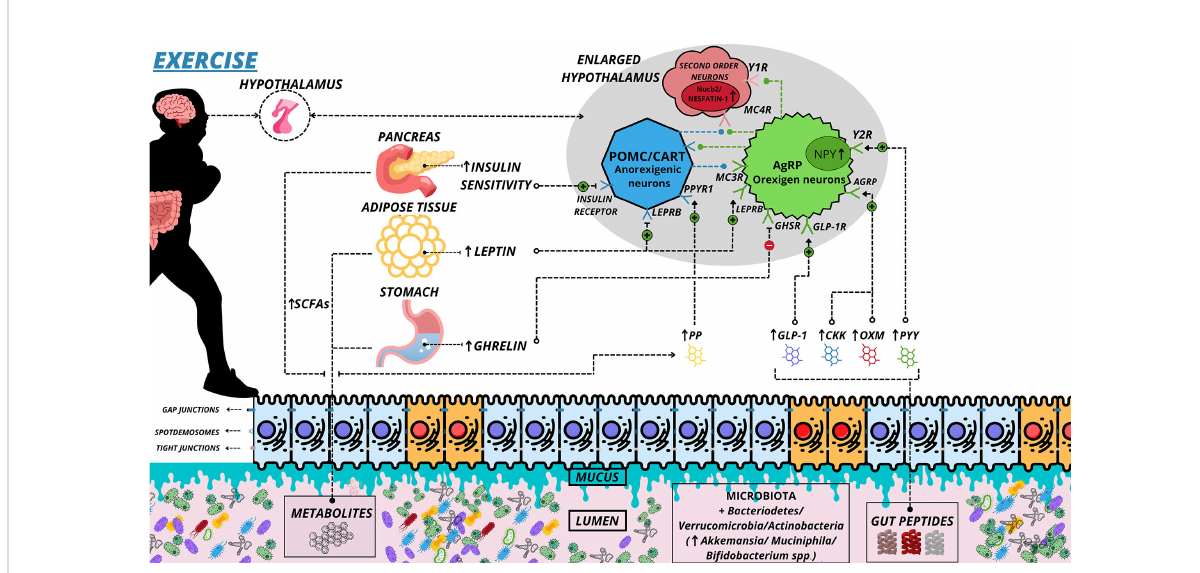
FIGURE 3 Alteration of the microbiota-gut-brain axis in exercise. Main hormonal changes in response to physical exercise. Exercise can maintain the health of epithelial cells, and cell communications remain healthy, without permeability of substances to systemic circulation. Mucus preservation and improved interaction of peptides/hormones with their receptors also occur, creating optimal conditions. Blue cells represent healthy. ( ↑ ) Increase Secretion and Greater; ( ↓ ) Decrease Secretion and Decline; ( ⊕ ) Positive interaction; ( ⊖ ) Negative Interaction; ( ⊘ ) Non Interaction; SCFAs, Short-Chain Fatty Acid; PYY, Peptide YY; OXM, Oxytomodulin; PPYR1, Pancreatic Polypeptide Receptor 1; PP, Pancreatic Polypeptide; GLP-1, Glucagon Like Peptide-1; GLP-1R, Glucagon Like Peptide-1 Receptor; LEPRB, Leptin Receptor Long Isoform; Y1R, Neuropeptide Y Receptor type 1; Y2R, - Neuropeptide Y Receptor type 2; GHSR, - Growth Hormone Secretagogue receptor; CKK, Cholecystokinin; MC3R, Melanocortin 3 Receptor; MC4R, Melanocortin 4 Receptor; AgRP, Agouti-Related